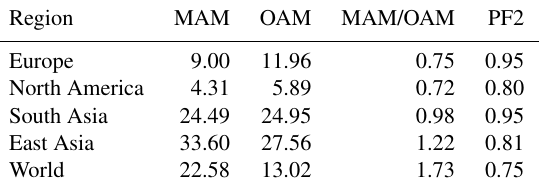
Table 1. Summary of the comparison of model data to pseudo- observations of PM 2 . 5 concentrations (van Donkelaar et al., 2010). OAM and MAM are the spatial arithmetic mean of the observations and of the model results (REF simulation), respectively (in µgm − 3 ), based on the annual averages. The model results were masked in lo- cations where no observations are available. PF2 is the percentage of model results within a factor of 2 of the observations.